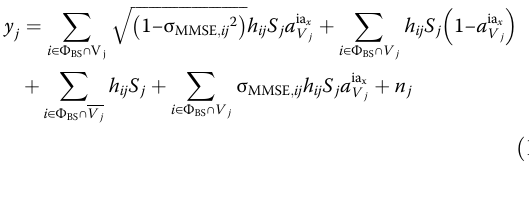
(cid:4)q ffiffiffiffiffiffiffiffiffiffiffiffiffiffiffiffiffiffiffiffiffiffiffiffiffiffiffi 1 − σ MMSE ; ij 2 (cid:3)